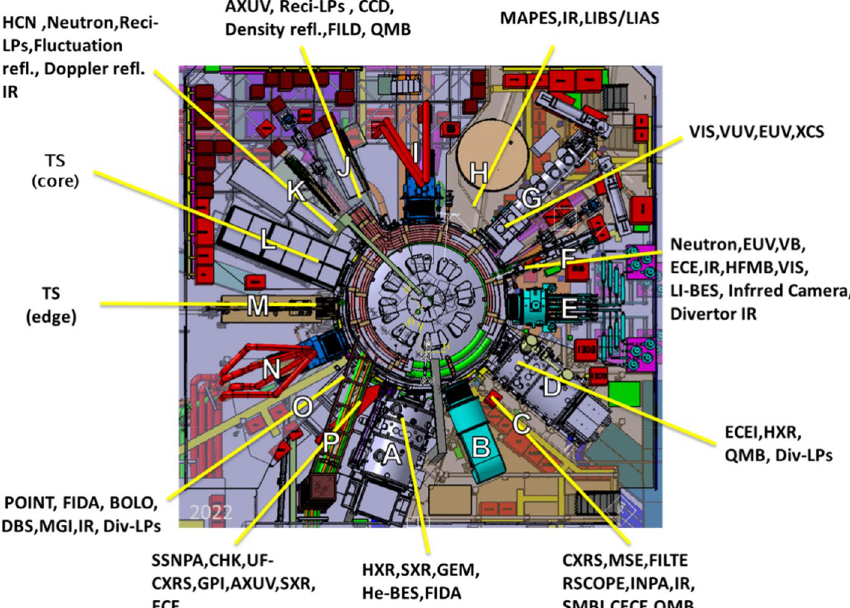
Fig. 6 The layout of diagnostics on EAST. Nearly 80 diagnostics are distributed on 12 different midplane ports and integrated with the machine and auxiliary heating